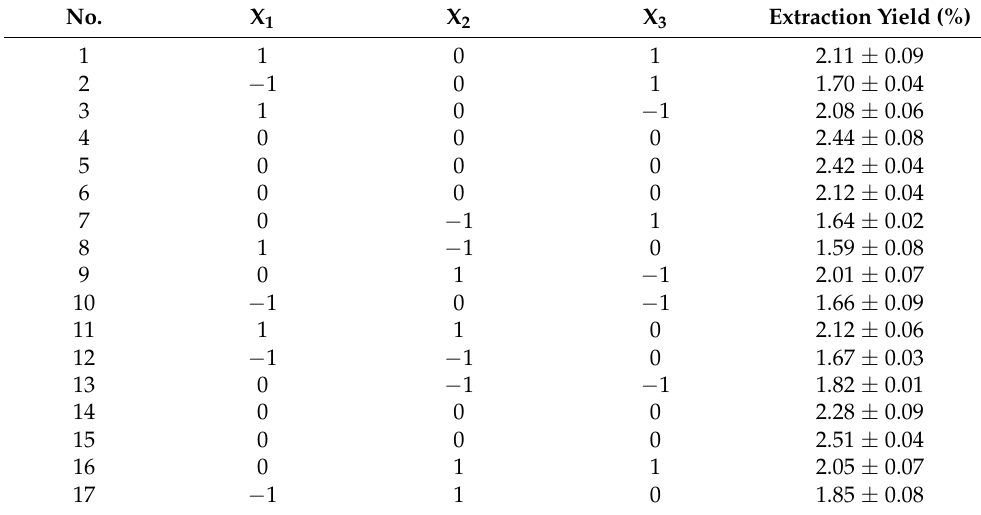
Table 3. Response surface optimization design and results.